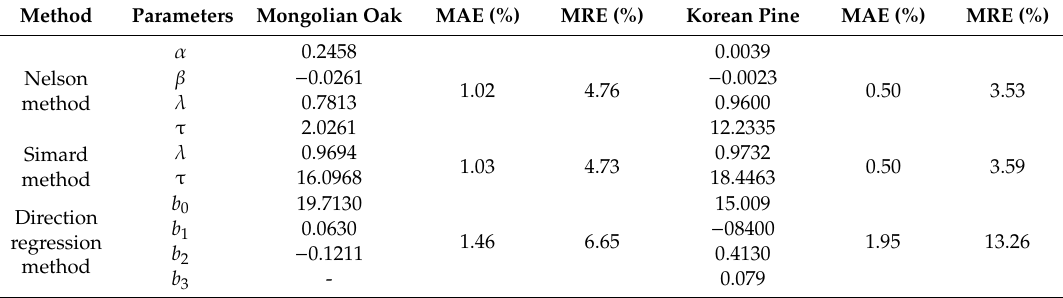
Table 3. Estimated parameters and errors of all the models established using three di ff erent methods. MAE and MRE indicates the mean absolute error and mean relative error,